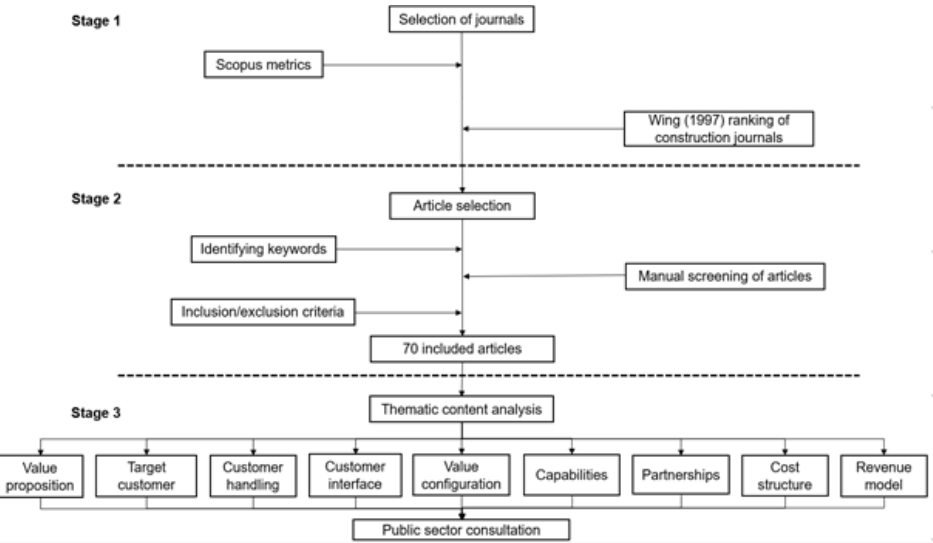
Figure 5. Research